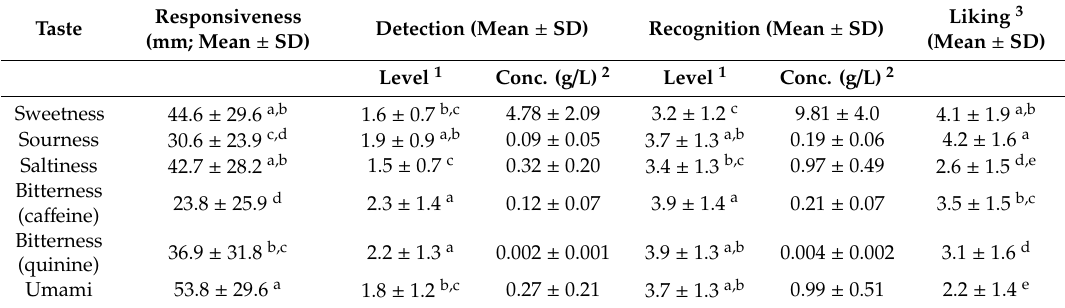
Table 4. Children’s taste sensitivity (responsiveness, DT, and RT) and liking of basic taste